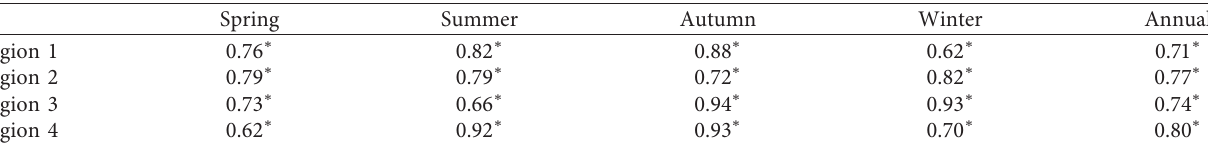
Table 1: Correlation coefficients for multiple linear regressions conducted between annual and seasonal all-sky LER (W m − 2 ) and cloud (%), Ta ( ° C), and RH (%) in four climatic regions. The asterisk means correlations significant at the 95% significance level.